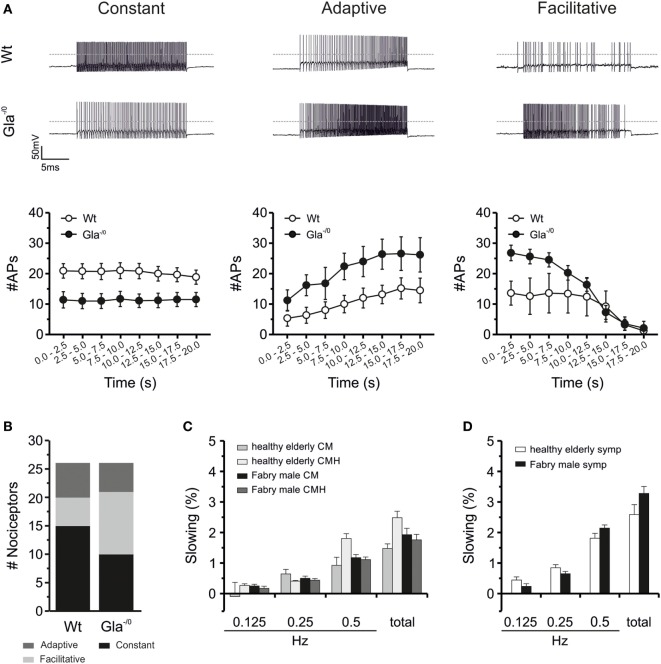
Electrical properties of Gla−/0 cultured sensory neurons and activity-dependent slowing of human C-fibers. (A) Action potential (AP) generation upon prolonged depolarization significantly changes in adult Gla−/0 nociceptors. In matured nociceptors, the constant firing rate in Gla−/0 nociceptive neurons is decreased (left panel) and the facilitative and adaptive firing frequency is increased (middle and right panels, respectively). (B) Furthermore, nociceptors from Gla−/0 mice show an elevated amount of neurons that display a facilitative firing at adult ages and a reduction in the neurons that generate a constant AP firing frequency. (C) Activity-dependent conduction velocity slowing (ADS) in C-fibers from patients with M. Fabry and healthy elderly controls showed no significant differences in ADS between heat-responsive and -unresponsive C-fibers. In the left panel, ADS of mechano-responsive C-fibers with (CMH) and without heat response (CM) to electrical stimulation with different frequencies (0.125, 0.25, and 0.5 Hz) and the sum of these ADS steps are depicted. (D) ADS of sympathetic C-fibers is shown. No significant differences were found in ADS between patients with M. Fabry and healthy controls.